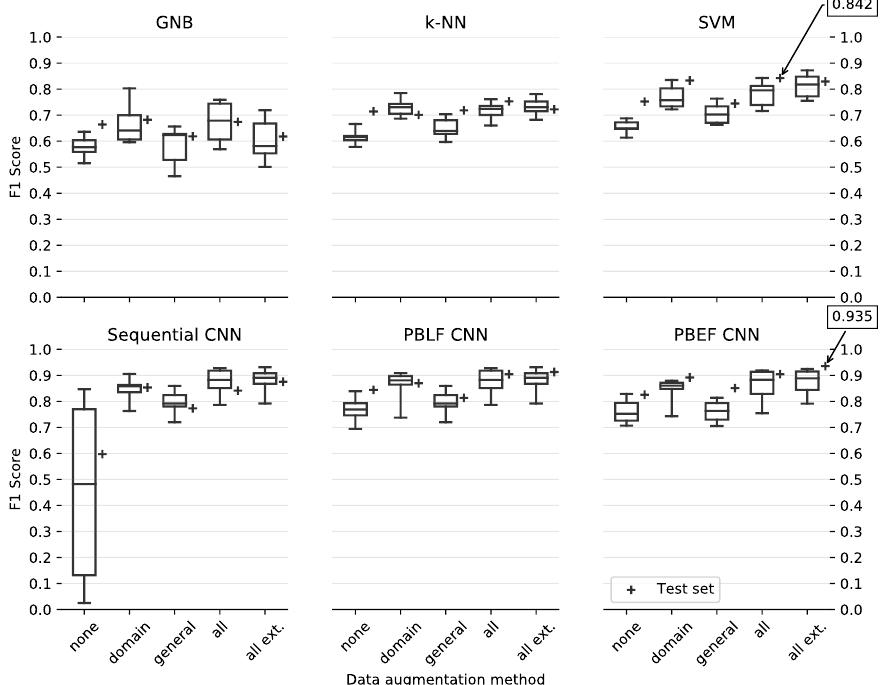
Figure 11. Box plot for the person-independent user evaluation is depicted on the right. The + indicates the performance of our test